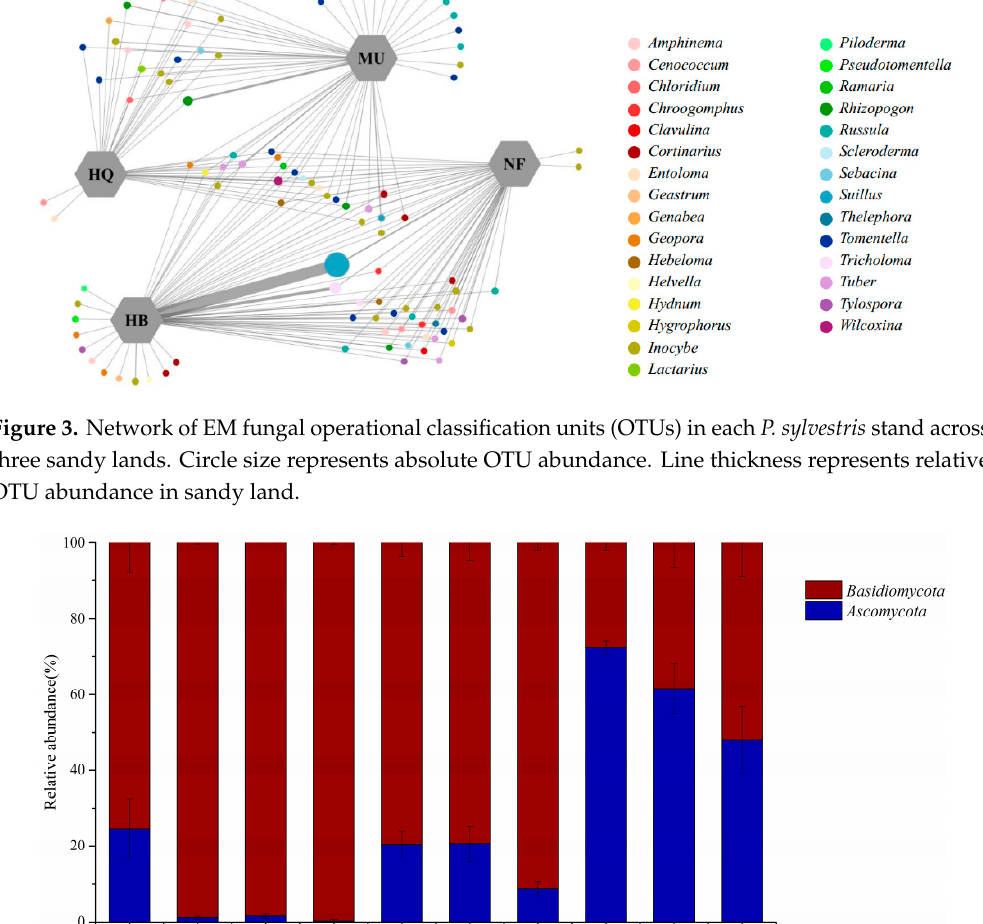
Figure 4. Relative abundance of EM fungal phyla in each P. sylvestris stand across three sandy lands.